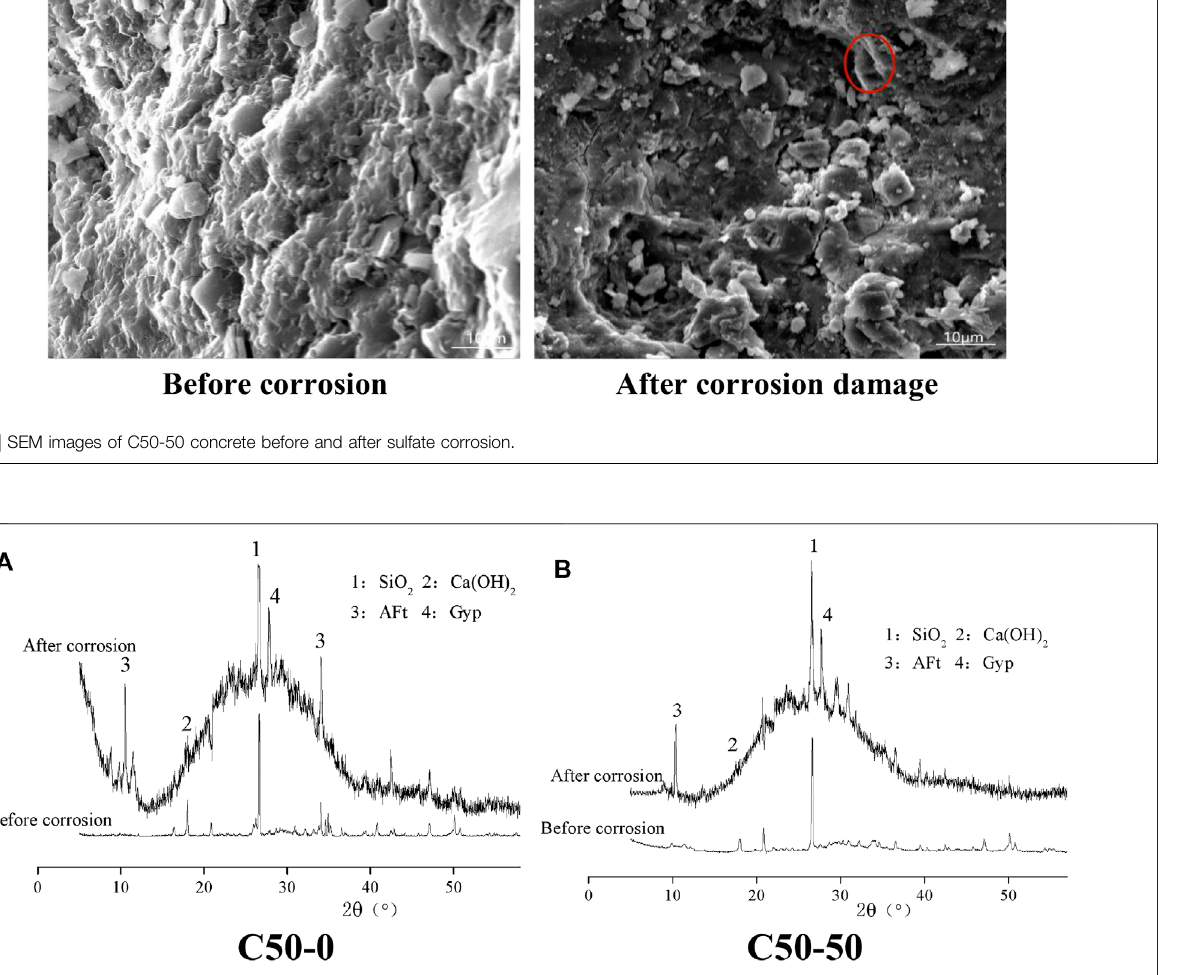
FIGURE 6 | XRD spectrum of concrete before and after sulfate corrosion